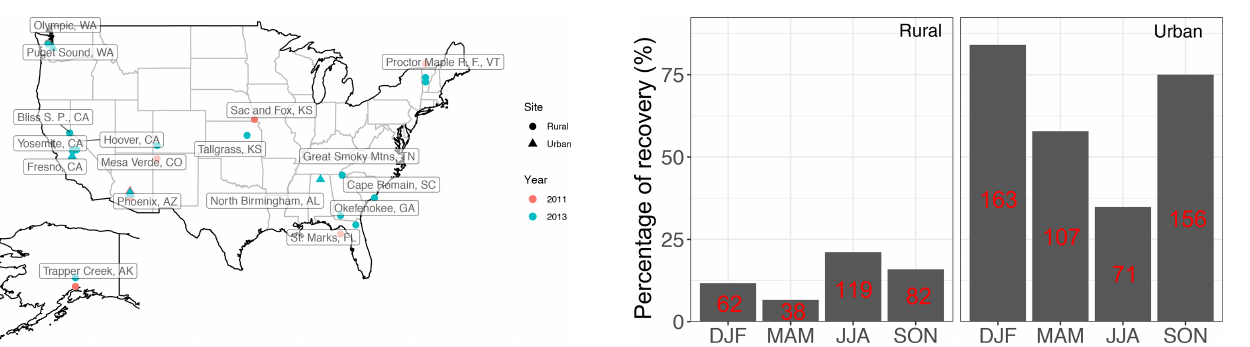
Figure 4. Percentage of the samples which were recovered from each category (sample type and season) after baseline correction. The number of samples in each category is shown in